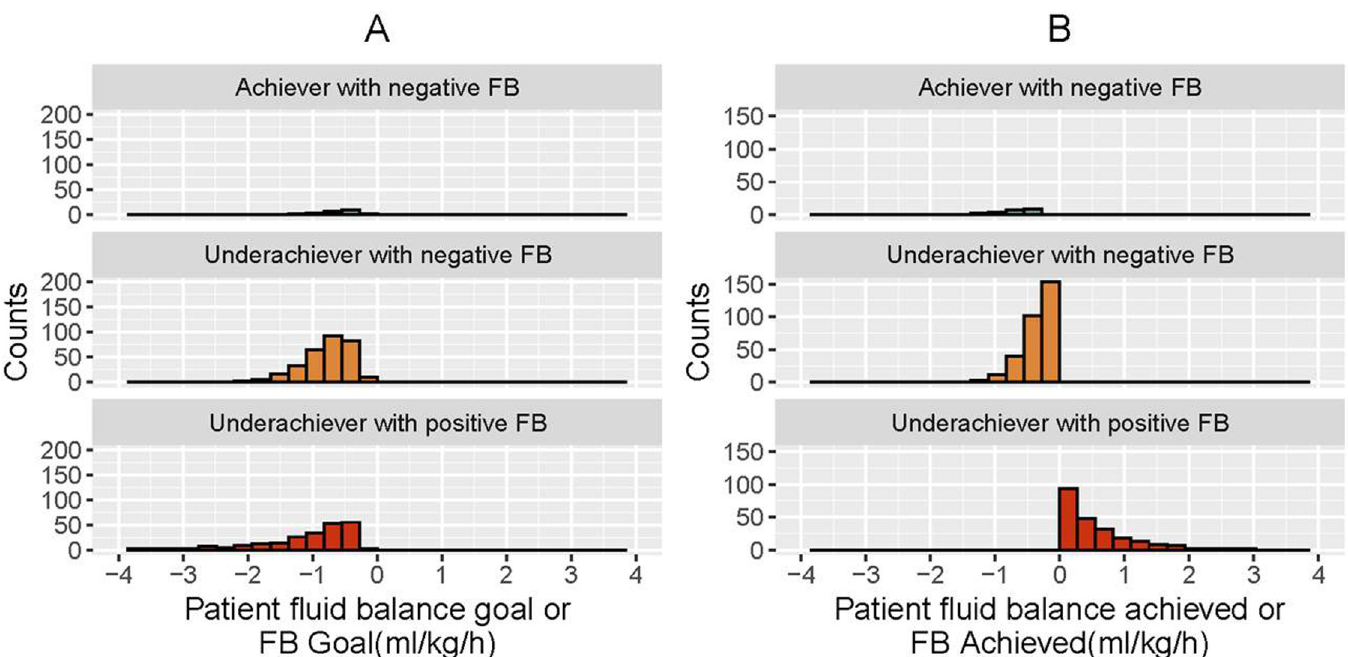
Fig 3. Graphic representation of patient FB Goal (ml/kg/h, Panel A) and FB Achieved (ml/kg/h, Panel B) classified in 3 clinical subgroups: 1) underachiever with positive fluid balance (red); 2) underachiever with negative fluid balance (orange); and 3) achiever with negative fluid balance (green). For visualization, data represented in the Figure exclude < 2.5 and > 97.5 percentiles.